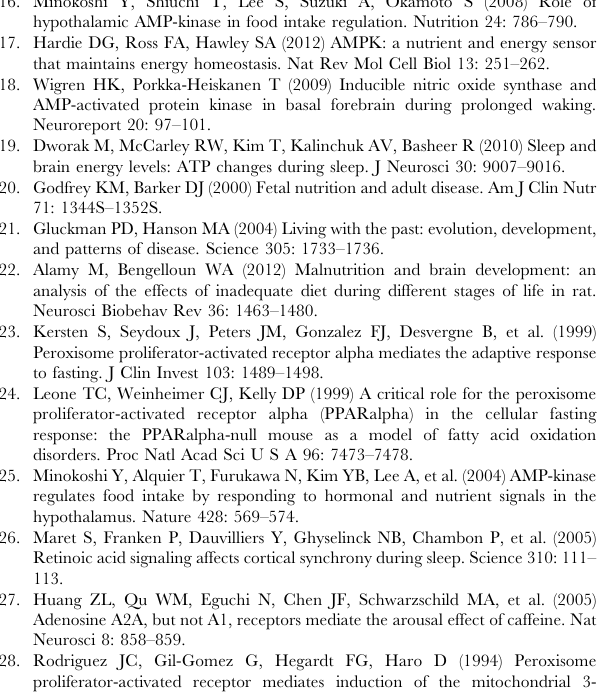
Figure S6 Total time of immobility and changes in DR offspring mice treated with vehicle (Vhe; saline) or therapeutic drugs in the forced swim test. As therapeutic drugs, we used fluoxetine (Flu), imipramine (Imi), and phenelzine (Phe). Each therapeutic drug was injected intraperitoneally 30 min before the forced swim test. Open bars indicate AD mice. Closed bars indicate DR mice. Data